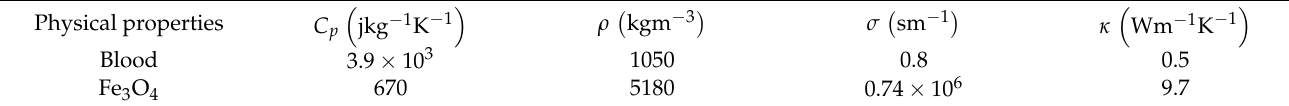
Table 2. The values of thermophysical properties of blood and Fe 3 O 4